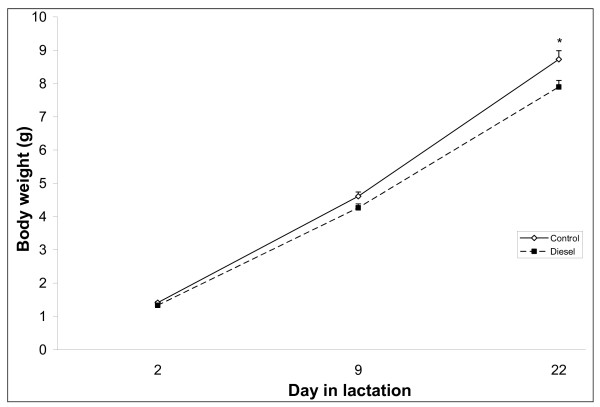
Average litter weight during lactation. Litters were either controls or exposed to DEP during gestation. Data represent mean+SEM. Mean Offspring exposed to DEP during fetal life gained statistically significantly less weight during the latter half of lactation compared to control offspring. n = 12. *p < 0.05.